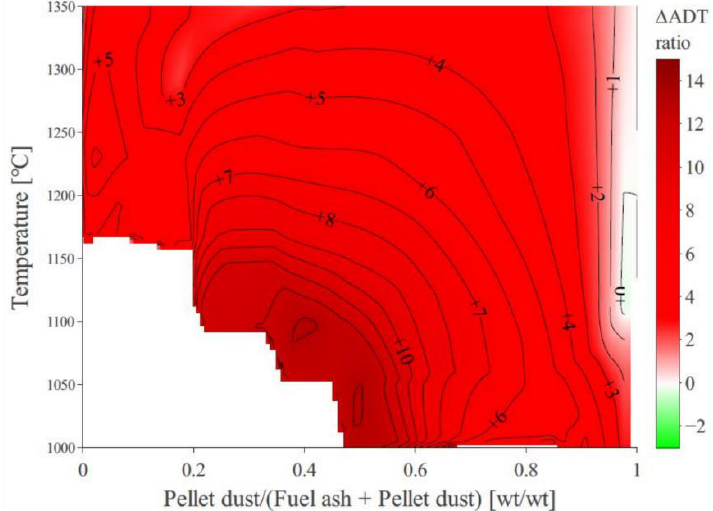
Figure 7. Plot of Δ(ADT) comparing the slagging tendency [g/kg ash input] of coal and raw stem Figure 7. Plot of ∆ (ADT) comparing the slagging tendency [g / kg ash input] of coal and raw stem wood wood when mixed with pellet dust. Δ(ADT) = (ADT) stem wood − (ADT) coal . Contours indicate Δ(ADT). when mixed with pellet dust. ∆ (ADT) = (ADT) stem wood − (ADT) coal . Contours indicate ∆